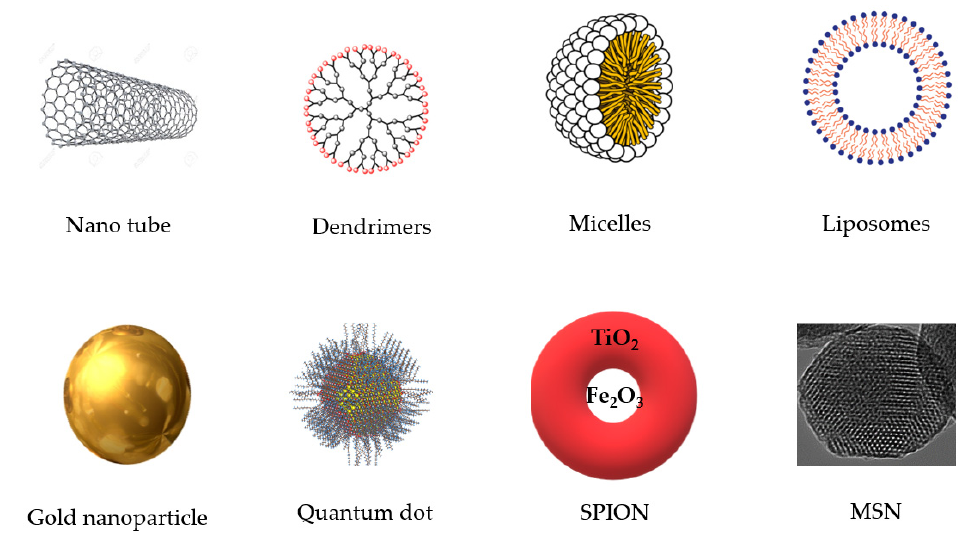
Figure 2. Eight di ff erent types of important nanocarriers. SPION: super paramagnetic iron oxide Figure 2. Eight different types of important nanocarriers. SPION: super paramagnetic iron oxide nanoparticles; MSN: mesoporous silica nanoparticles; MSN: mesoporous silica nanoparticles.